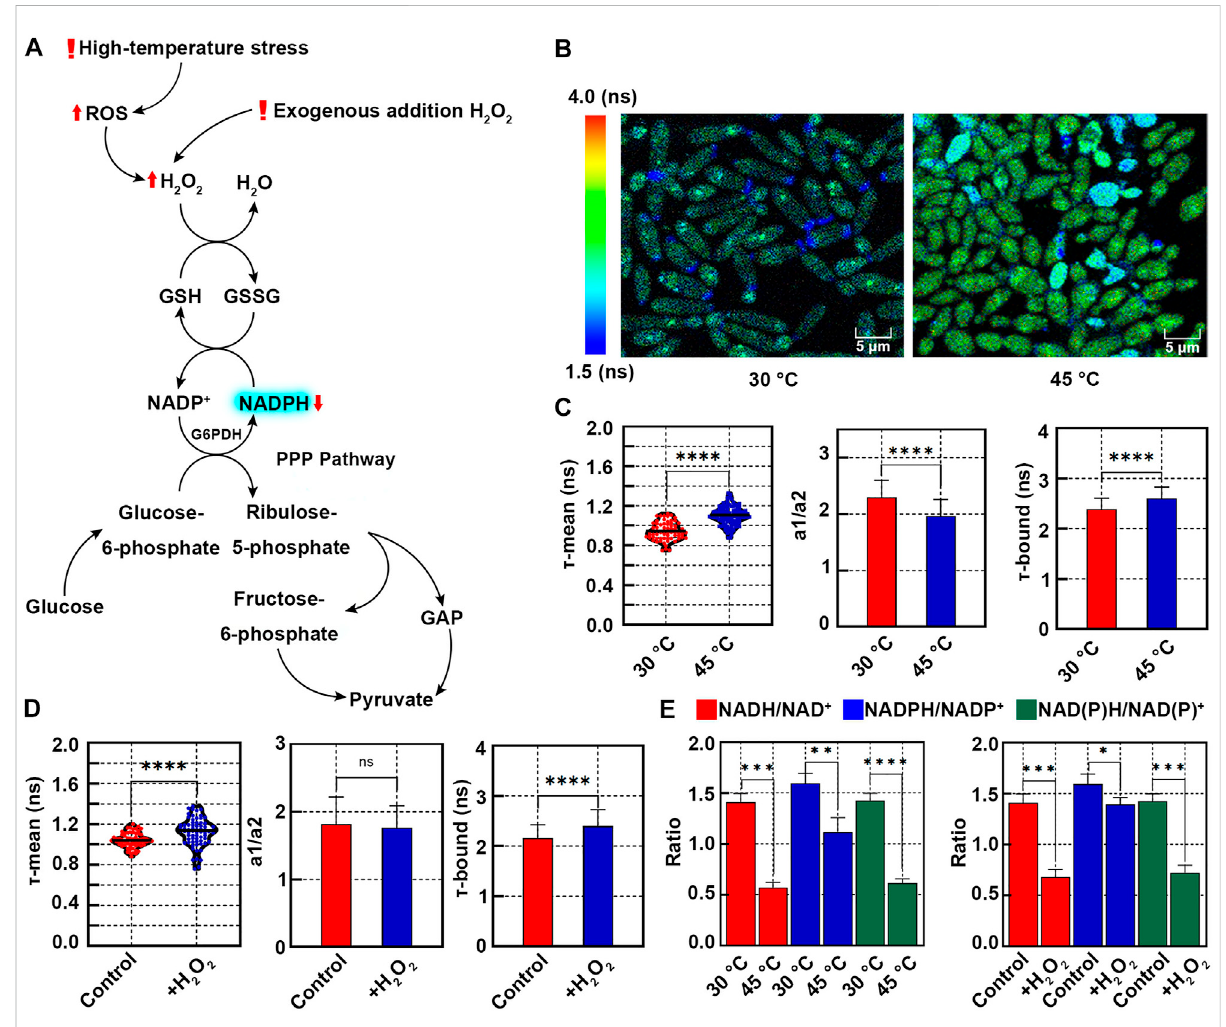
FIGURE 2 Redox states of K. marxianus cells upon oxidative stress induced by high-temperature or H 2 O 2 treatment. (A) Oxidative stress induced by high temperature or H 2 O 2 leads to the increased consumption of NADPH. (B) FLIM of NAD(P)H in cells grown at 30 ° C or 45 ° C. Pseudocolor mapping of NAD(P)H fl uorescence lifetimes was shown. The lifetime from 1.5 to 4.0 ns was assigned different colors. (C) Quantitative analysis of NAD(P)H fl uorescence lifetimes of cells in (B) . A violin plot showed the distribution of τ -mean of cells and the mean value was indicated by a black line. Histograms showed a1/a2 and τ -bound, in which values represented mean ± SD. A total of 68 cells grown at 30 ° C and 112 cells grown at 45 ° C were counted.**** p < 0.0001. (D) QuantitativeanalysisofNAD(P)H fl uorescencelifetimesofcellstreatedwithH 2 O 2 .Atotalof66controlcellsand69cells treated with H 2 O 2 were counted. “ ns ” indicated p > 0.05. (E) Ratios of NADH/NAD + , NADPH/NADP + and NAD(P)H/NAD(P) + of cells grown at